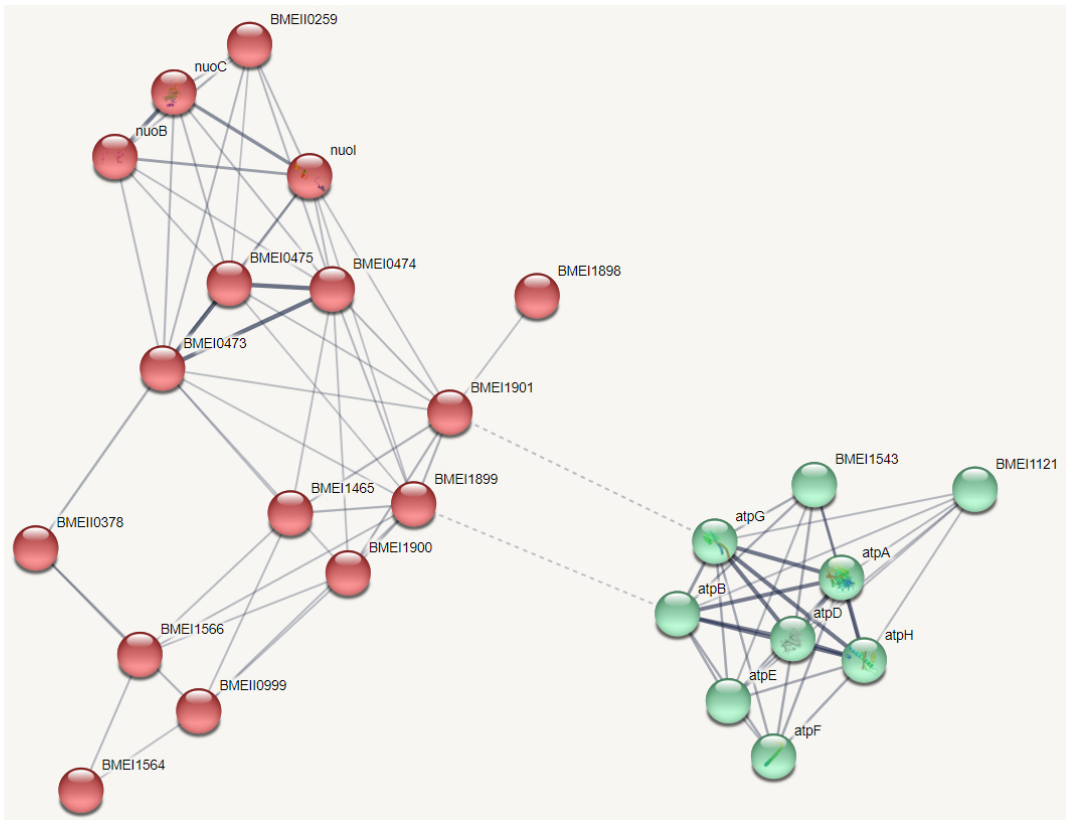
Figure 3. Protein–protein interaction network of 25 proteins whose gene expression was di ff erent between the neutral and acidic pH groups. In this network, 22 proteins are related to oxidative phosphorylation processes. The proteins in the network were divided into two clusters based on the distance matrix obtained from their global confidence scores. The proteins in the right cluster (green) are mostly ATP synthase subunits while the proteins in the left cluster (red) are mainly electron carriers. Inter-cluster edges are represented by dashed-lines.